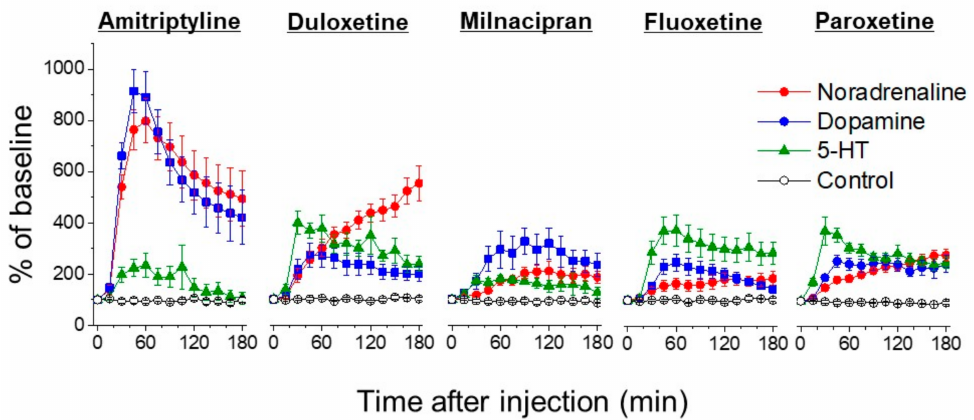
Figure 3. Percentage changes of noradrenaline, dopamine, and 5-HT levels in the dorsal horn of the lumbar spinal cord in rats after intraperitoneal injection of 10 mg/kg of amitriptyline (TCA), duloxetine (SNRI), milnacipran (SNRI), fluoxetine (SSRI) and Paroxetine (SSRI). Under isoflurane anesthesia, microdialysis studies ware performed after thoracolumbar laminectomy, and monoamines were measured by using high-performance liquid chromatography with electrochemical detection. All monoamines were increased after injection of all antidepressants (all p < 0.05 compared to control; saline or vehicle, by two-way repeated-measures analysis of variance. Some data in this figure published from Ref.